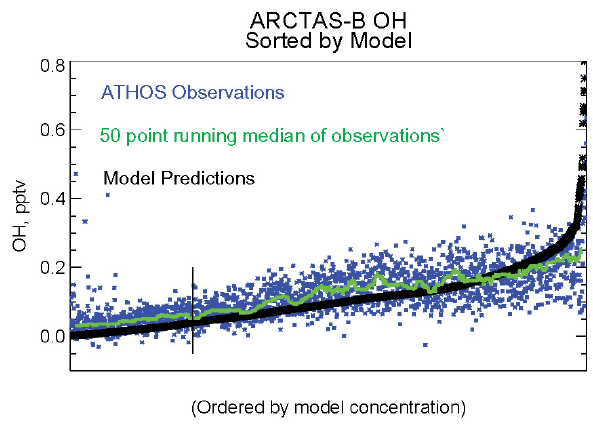
Fig. 11. Observed (blue) and model-predicted (black) concentra- tions pairs of OH during ARCTAS-B sorted by increasing model concentration. The green line shows a 50 point running median of observations along the sorted values.